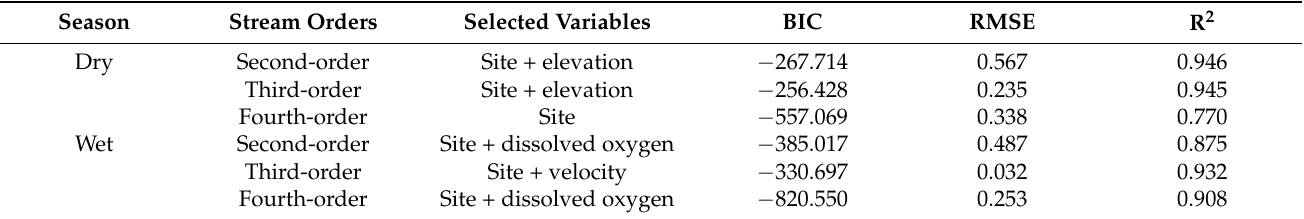
Figure 2. Relative contributions (i.e., mean values averages across species seasons) of abiotic environmental conditions, spatial factors and unexplained residuals underlying potential species associations to variation in fish community composition for different stream orders. Table 1. Model fit diagnostics and prediction errors for each Poisson log-normal (PLN) models.